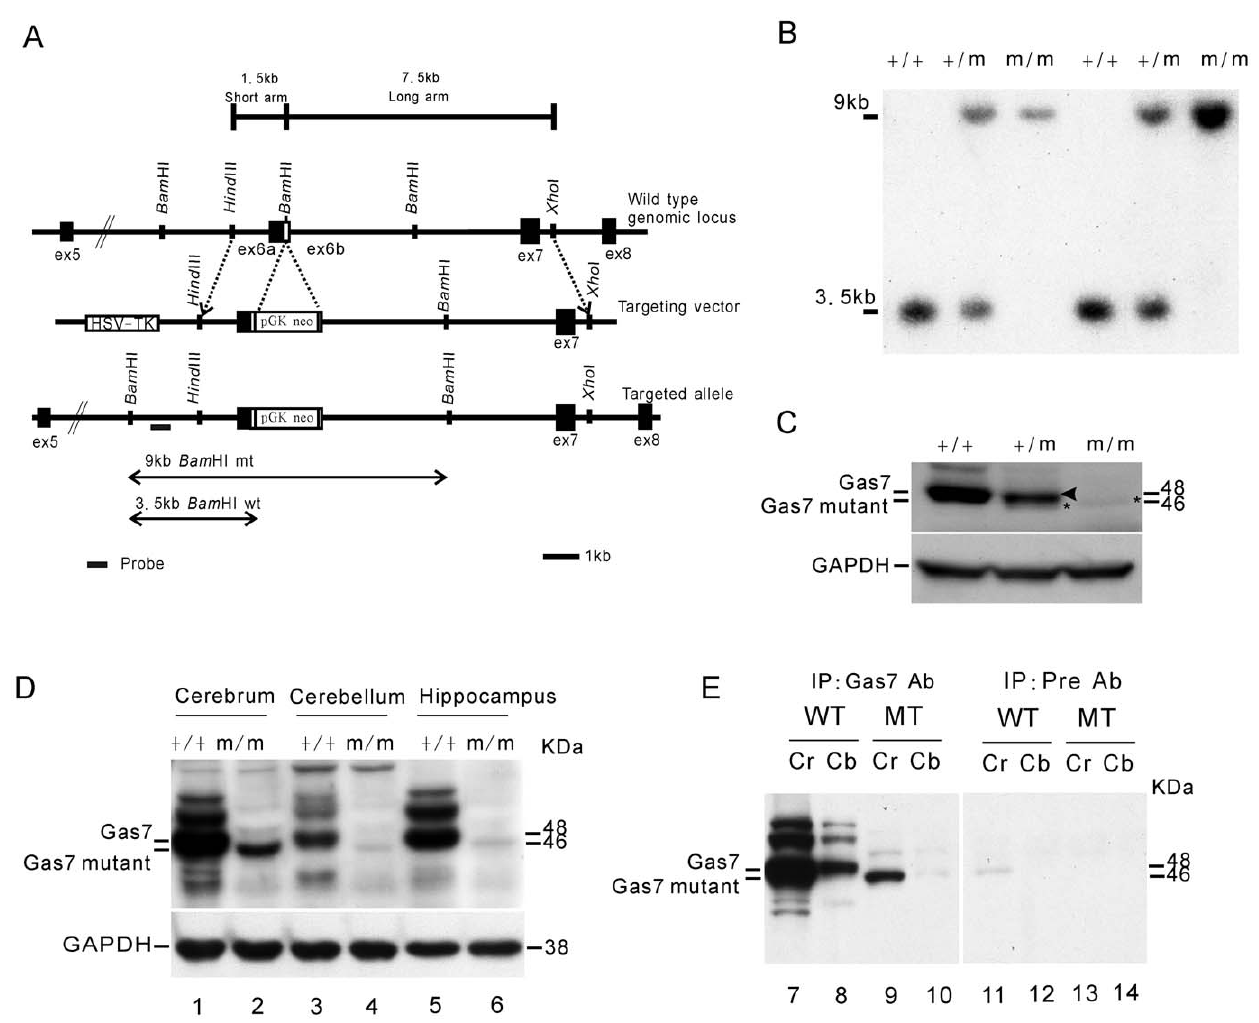
Figure 1. Disruption of gas7 gene and confirmation of Gas7 mutant protein expression. (A) Maps of the Gas7 wild-type ( + / + ) and mutant (m/m) alleles. The gas7 gene targeting vector contained a neo cassette inserted into the unique Bam HI site in exon 6 b. (B) Southern blot analysis of genomic DNA from gas7 + / + , gas7 + /m or gas7 m/m mice. Genomic DNA samples prepared from mouse tail were digested by Bam HI and hybridized with a probe specific to the region between exon 5 and 6 of the Gas7 gene (bar) to distinguish the wild-type alleles from mutants. The band at 3.5 kb indicates the wild-type allele harboring the Bam HI site. The 9 kb band represents the mutant allele, which was resistant to Bam HI digestion. (C) Expression of Gas7 was examined in brain lysates from gas7 + / + , gas7 + /m or gas7 m/m mice. Gas7-deficient mice generated a mutant protein (asterisk) smaller in size than the wild-type Gas7 (arrowhead). (D) Expression of Gas7 and Gas7 mutant were examined in three brain regions including cerebral cortex, cerebellum, and hippocampus of wild-type and deficient mice. (E) Gas7 mutant expression in the cerebrum and cerebellum of the Gas7- deficient mice was confirmed by IP-Western using anti-Gas7 antibody. Gas7 mutant protein was not detected by pre-immune antibody in the cerebrum or cerebellum of the Gas7-deficient